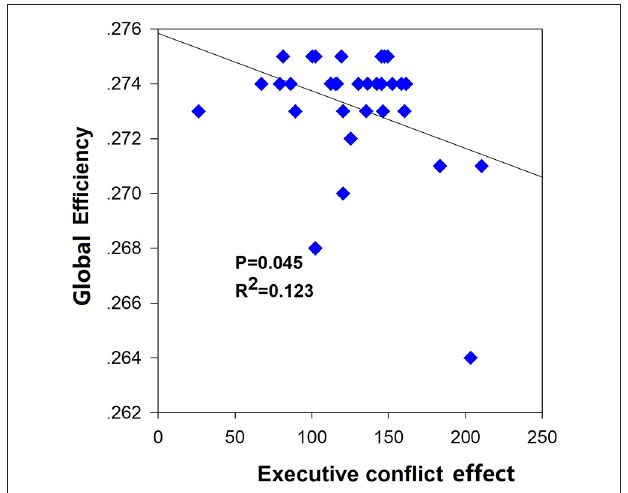
FIGURE 5 | Significant negative correlation between global efficiency and executive conflict